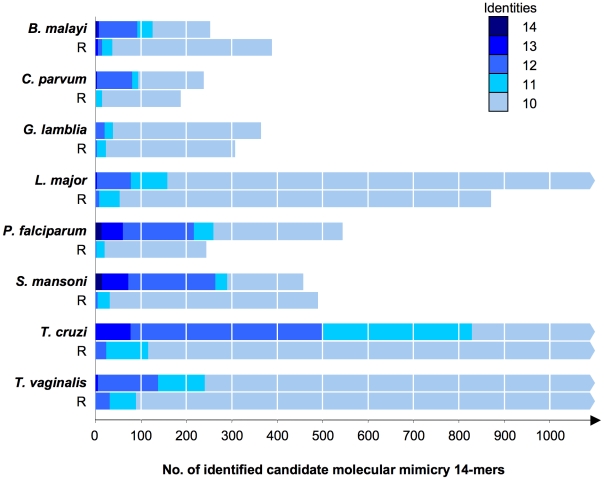
Numbers of identified candidate molecular mimicry 14-mers from parasite proteomes and randomized versions thereof (R).Numbers of amino acid identities between the 14-mers and their best hit in the human proteome are color-coded as indicated.